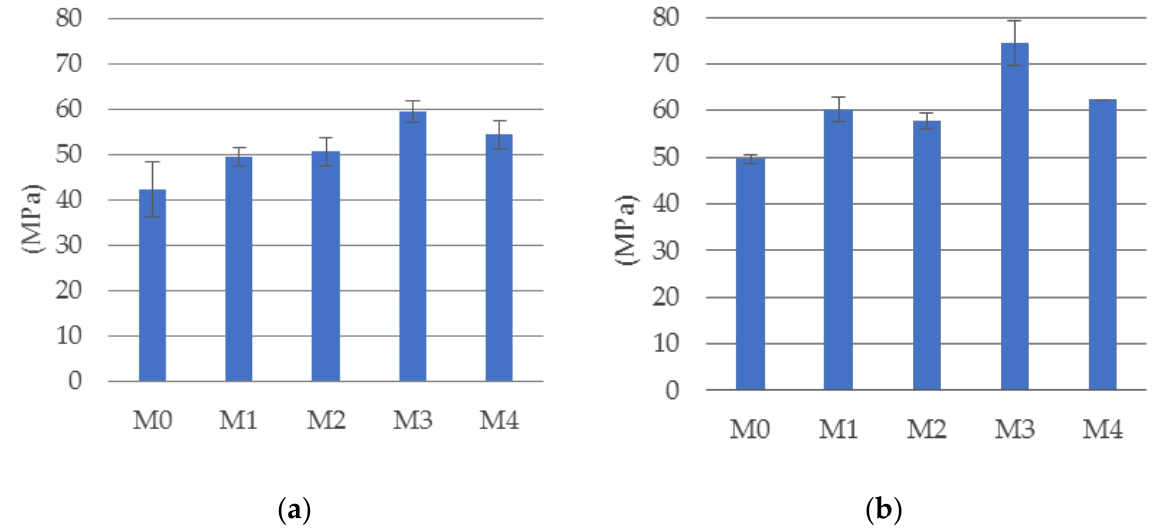
Figure 4. The mean compressive strength of cubic samples at ( a ) 28 and ( b ) 56 days.